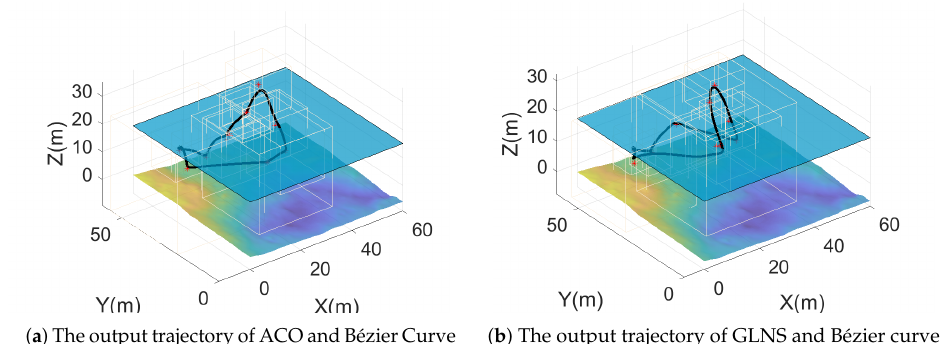
Figure 16. A comparison of the trajectories generated with the GLNS path and the ACO path using a Bézier curve. KD trees, corridors, and whole trajectories are illustrated. In this scenario, the weighted length of the ACO trajectory was 924.6468, and GLNS’s was 645.4758.